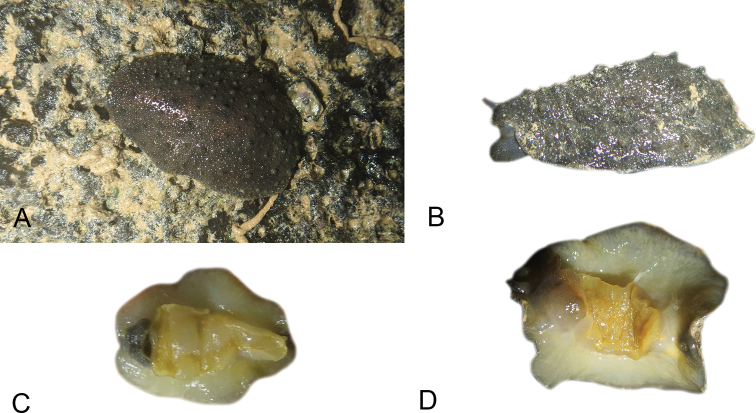
Live animals, Peronia
platei, Hawaii, Oahu A dorsal view, 30 mm long [6161] (BPBM 284528) B dorsal view, 30 mm long [6160] (BPBM 284527) C ventral view, same as A; D ventral view, same as B.